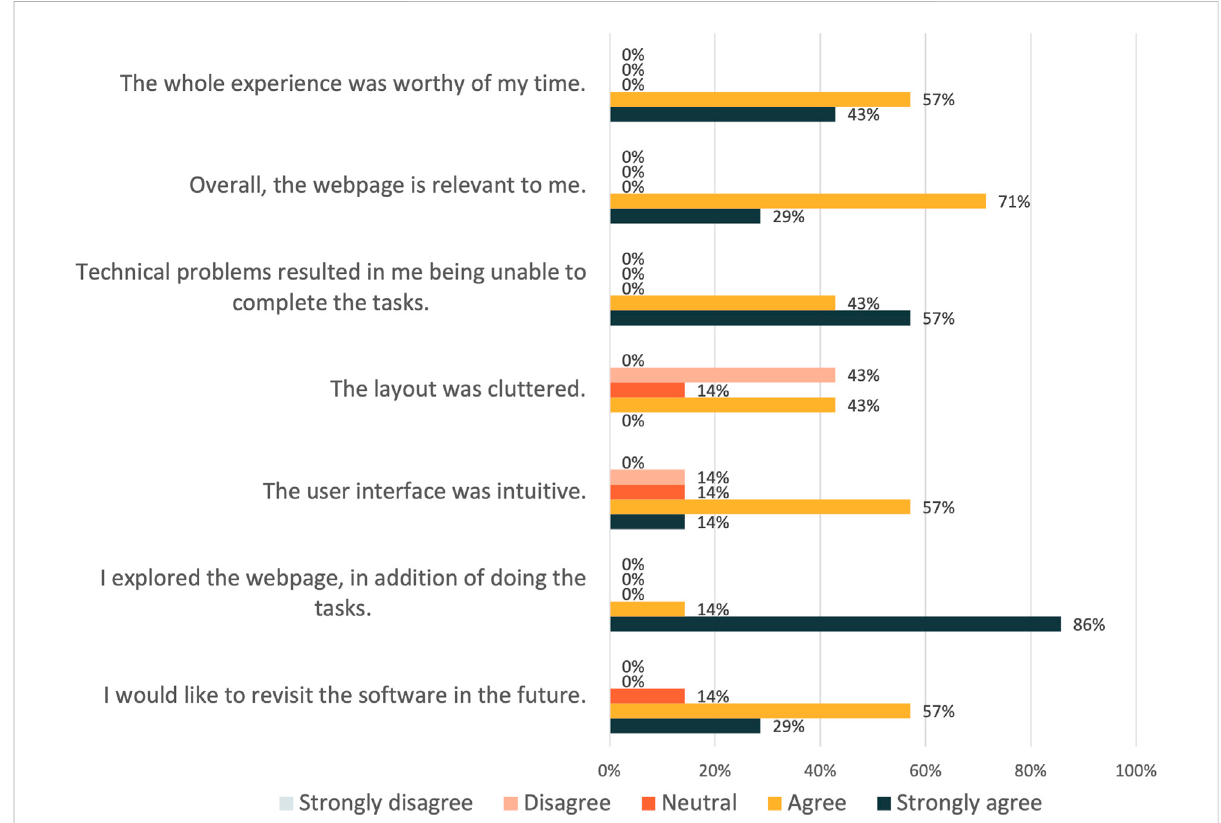
FIGURE 8 Student ’ s perspective about the usability and functionality provided by FermProc (later BioVL